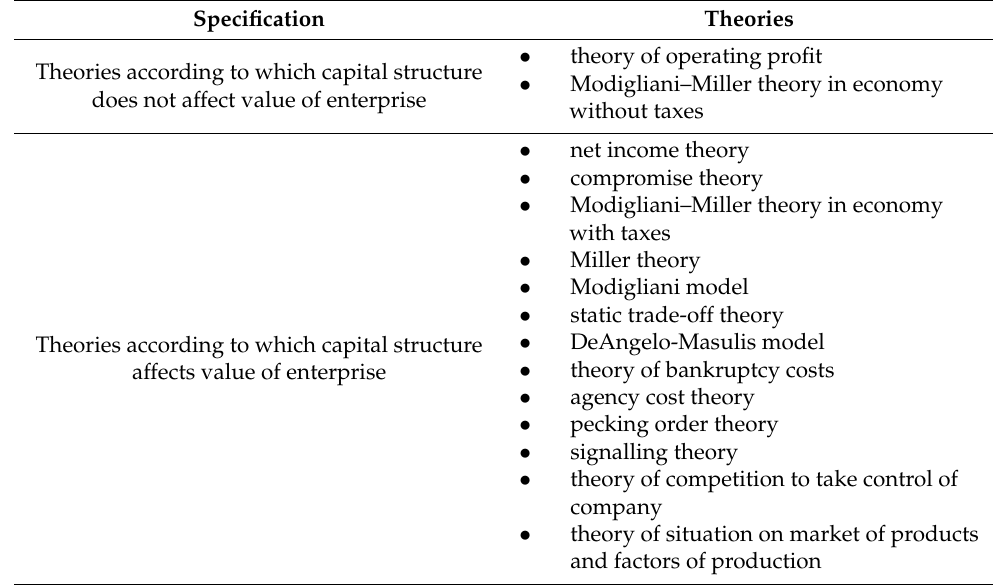
Table 3. Classification of capital structure theories from the perspective of its impact on corpo- rate